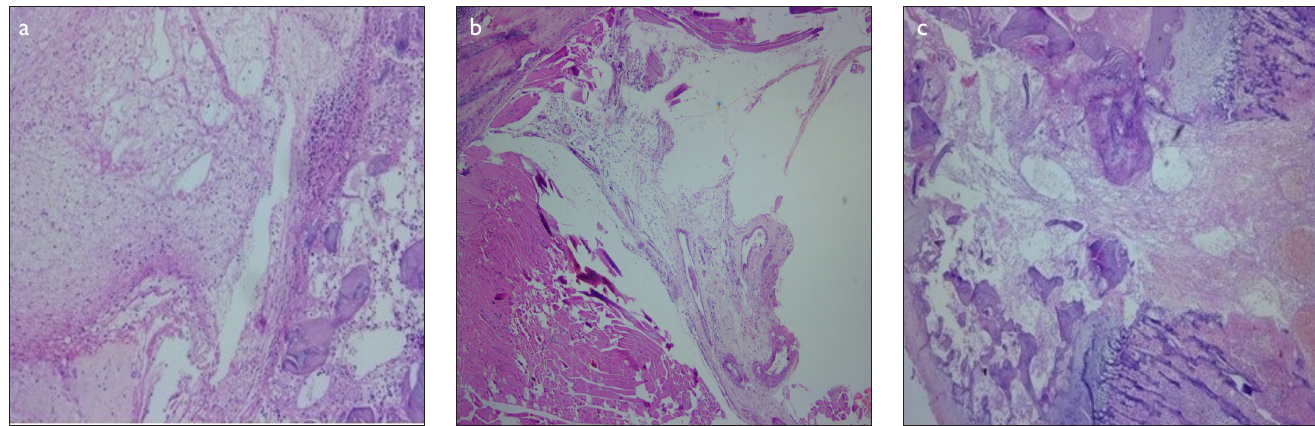
Figure 1. a-c. Hematoxylin-eosin staining of soft tissue inflammation (10x magnification). (a) Saline, (b) 0.5% NaOCl, and (c) 5% Table 1. Descriptive statistics and Kruskal Wallis test results Evaluated